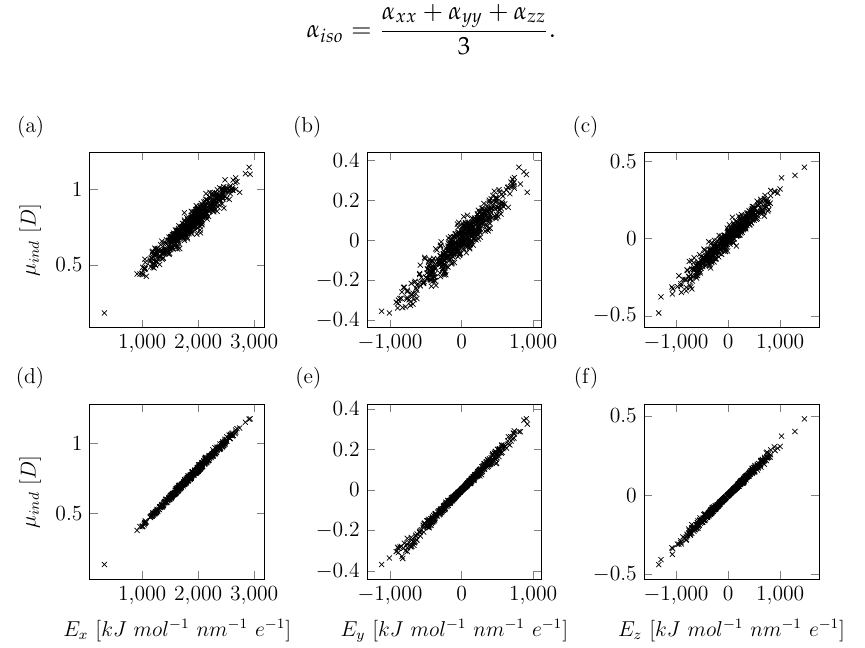
Figure 3: Fitted induced dipole moments ( µ ind ) in the presence of an external electric field ( E ), plotted for each separate dimensional component (x, y or z). In panels a-c the results obtained using our original method (with updated E calculation) are presented, where induced dipoles of the QM solute were fitted independently for each individual solvent configuration obtained from MD. The x, y and z components of this induced dipole are presented in panels a, b and c, respectively. Panels d-f present the results of our consensus fitting approach, where 20 independent solvent configurations are used simultaneously in each constrained fit of the induced dipole moments. The x, y and z components of these induced dipoles are presented in panels d, e and f, respectively.